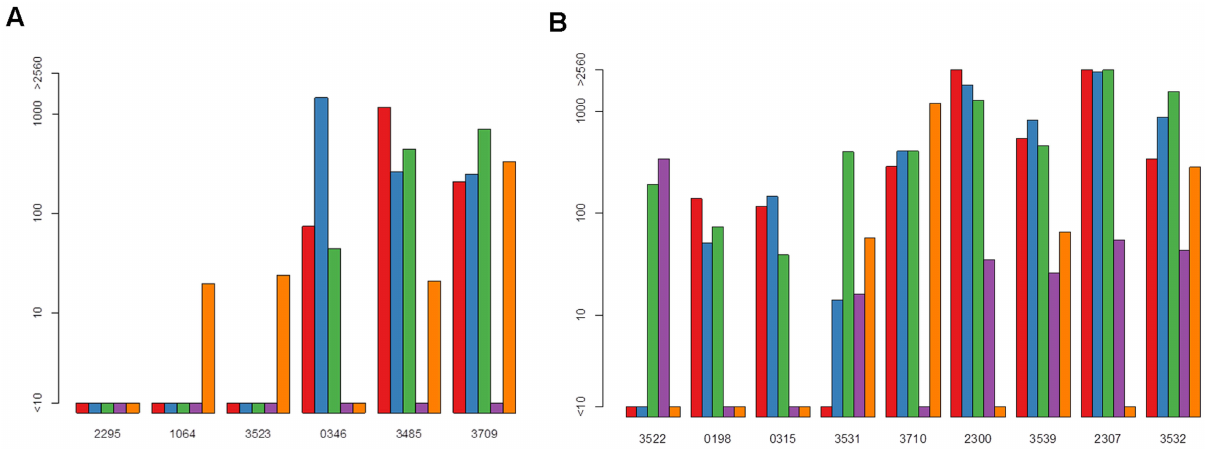
Figure 2. Pre-exposure neutralizing antibody titers (NTs) in dengue virus serotype 4 (DENV-4) ‘‘susceptible’’ and ‘‘non-susceptible’’ subjects. Graphs show: (a) six DENV-4 PCR positive (‘‘susceptible’’) subjects; (b) nine DENV-4 PCR negative (‘‘non-susceptible’’) subjects. NTs for each subject are against the reference strains for DENV-1, -2, -3, -4 and Japanese encephalitis virus (JEV) (red, blue, green, purple and orange, respectively). using homotypic DENV-1 NTs (AUC= 0.833 [95% CI 0.590, 1.000]) than heterotypic NTs (Table 3). For DENV-4 clusters, age-adjusted models were better using homotypic DENV-4 NTs (AUC = 0.889 [95% CI 0.667, 1.000]) than heterotypic NTs (Table 3). For DENV-2 clusters, age-adjusted models were better using both homotypic DENV-2 reference NTs (AUC = 0.740 [95% CI 0.460, 0.960]) and heterotypic DENV-4 reference NTs (AUC = 0.880 [95% CI 0.680, 1.000]) than other heterotypic NTs (Table 3). When different DENV-2 strains were used for PRNT, the AUC using Asian I 1974 strain appeared to have the best fit.